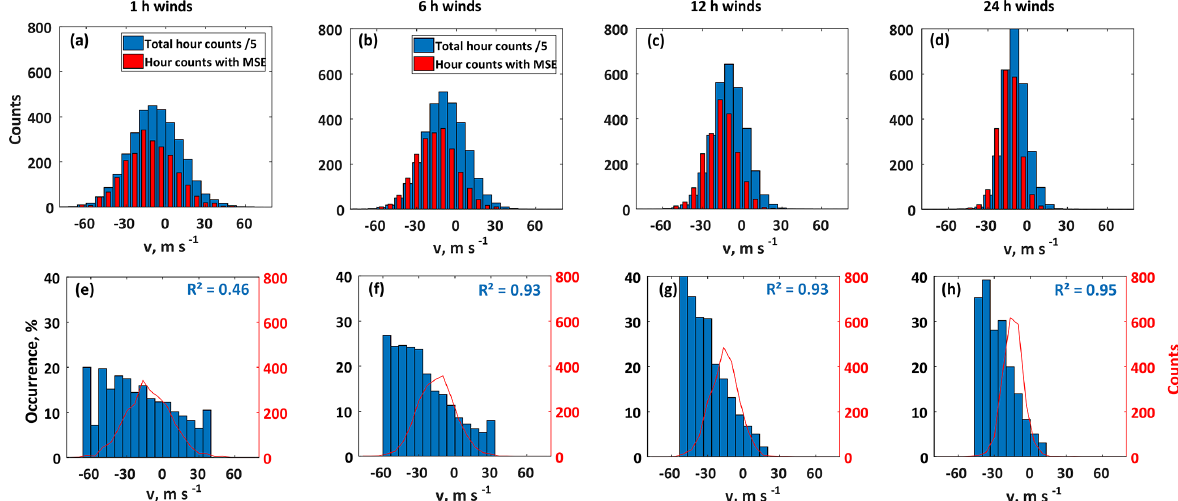
Figure 6. Dependencies of MSEs on meridional transport, quantified by the hourly meridional winds obtained by the Juliusruh meteor radar. In the top row (a–d) , the total counts of OSWIN observation hours (divided by a factor of 5) are shown by blue bars for each bin of meridional wind speed, and the counts of hours with MSEs detected are shown by red bars. In the bottom row (e–h) , the occurrences of MSEs vs. meridional wind are shown by blue bars, and the red lines indicate the number of counts with MSEs detected. Correlation coefficients between the occurrence of MSEs and meridional winds are shown by blue